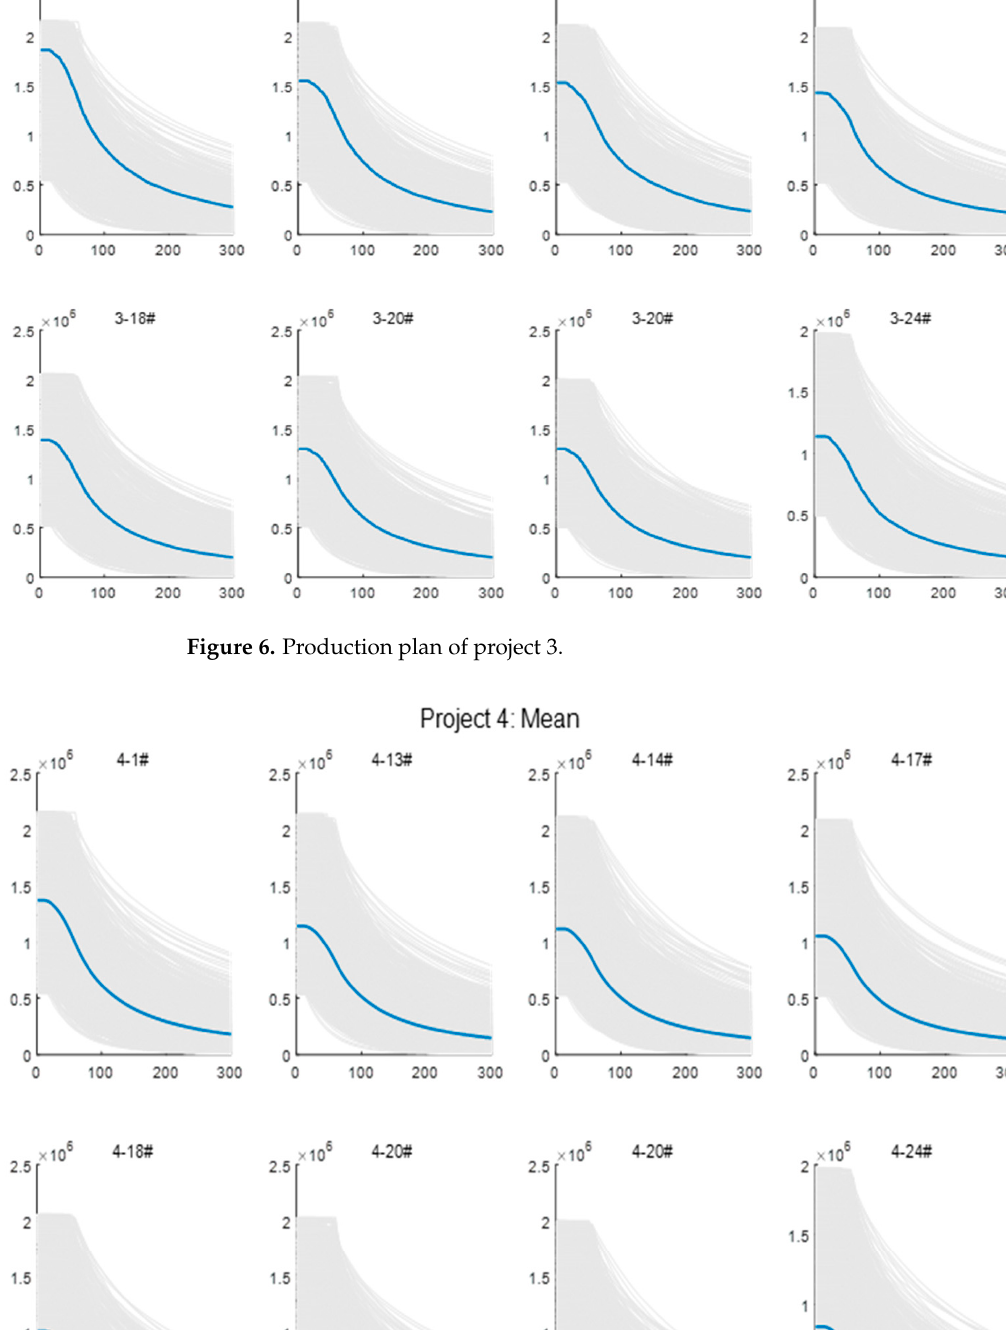
Figure 7. Production plan of project 4.